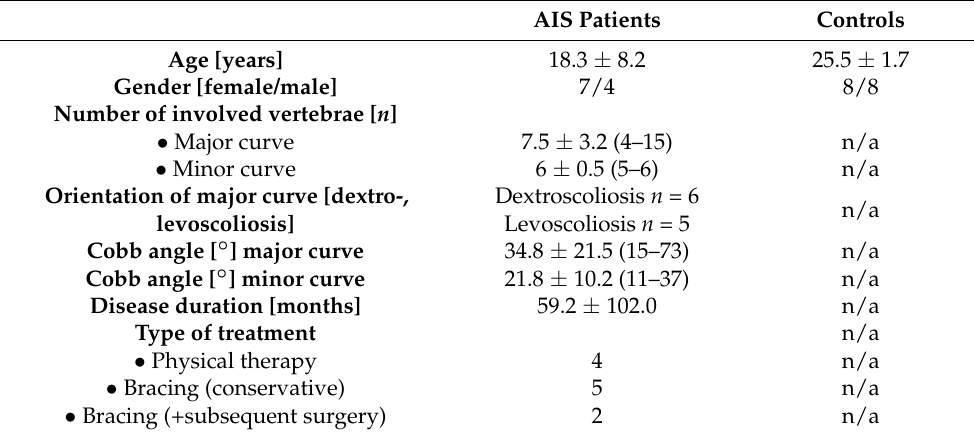
Table 1. Demographic, clinical, and therapeutic information of the study